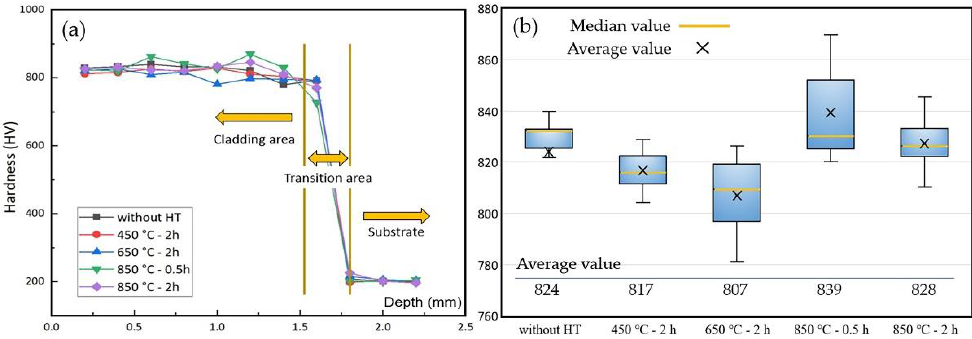
Figure 10. Coating microhardness test results: ( a ) hardness along the depth; ( b ) hardness boxplot of the coating cladding area.